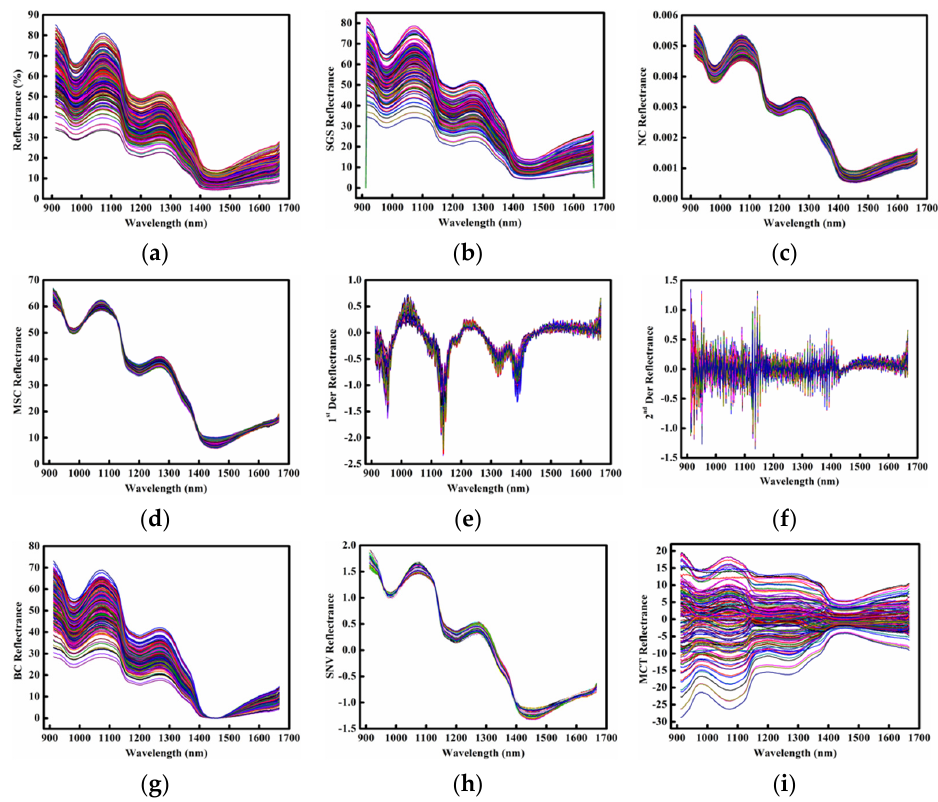
Figure 2. Spectral characteristics of citrus peel samples (249 curves with different colors). ( a ) Raw spectra; ( b ) Savitzky − Golay smoothing (SGS) spectra; ( c ) normalization correction (NC) spectra; ( d ) multiple scattering correction (MSC) spectra; ( e ) 1st derivative (1st Der) spectra; ( f ) 2nd derivative (2nd Der) spectra; ( g ) baseline correction (BC) spectra; ( h ) standard normal variate (SNV) spectra; ( i ) mean centering transformation (MCT) spectra.